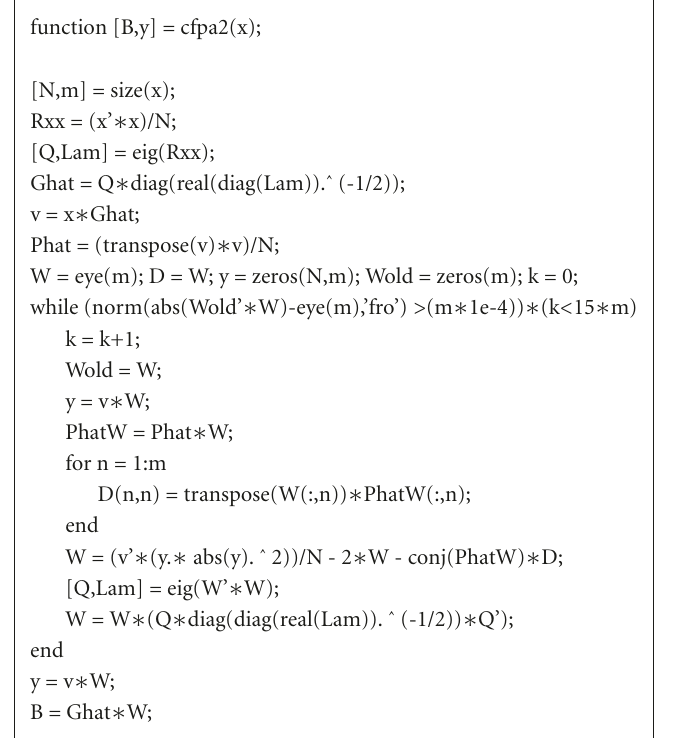
Algorithm 2: An implementation of our proposed fixed-point algorithm for complex-valued non-Gaussian source mixtures which uses symmetric orthogonalization.